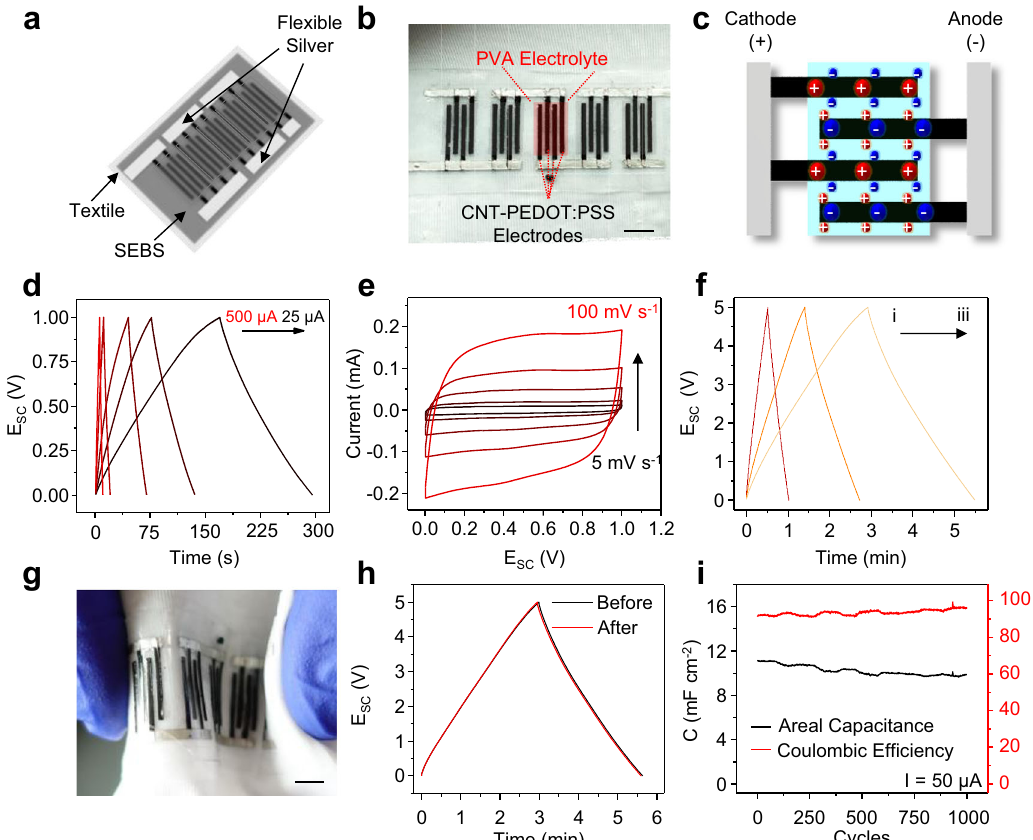
Fig. 4 Characterization of the performance of the SC modules. a Schematic image of the textile-based SC energy storage module consisting of current collectors, CNT-PEDOT:PSS-based electrodes and PVA-based solid gel electrolyte. Each module is composed of fi ve SC units connected in series. b The photo image of the printed SC module. Scale bar, 5 mm. c The charge storage mechanism of the hybrid SC unit based on both the double-layer capacitance and pseudocapacitance. d GCD with currents of 25, 50, 100, 250, and 500 μ A of a SC unit from 0 V to 1 V. e CV with scan rates of 5, 10, 25, 50, 100 mV s − 1 from 0 V and 1 V of a SC unit. f GCD of the energy storage modules with different con fi gurations, with (i) two storage modules in series; (ii) one storage module; and (iii) two storage modules in parallel. g Images of the inward and outward bending of the SC module. Scale bar, 1 cm. h 5 μ A GCD of the SC module before and after 1000 cycles of 180º bending deformation. i The areal capacitance and coulombic ef fi ciency of a SC unit in 1000 charge-discharge